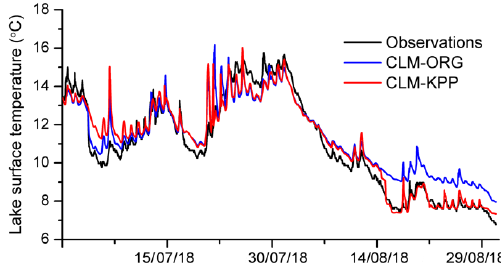
Figure 2. WST observations (black line) and simulations with